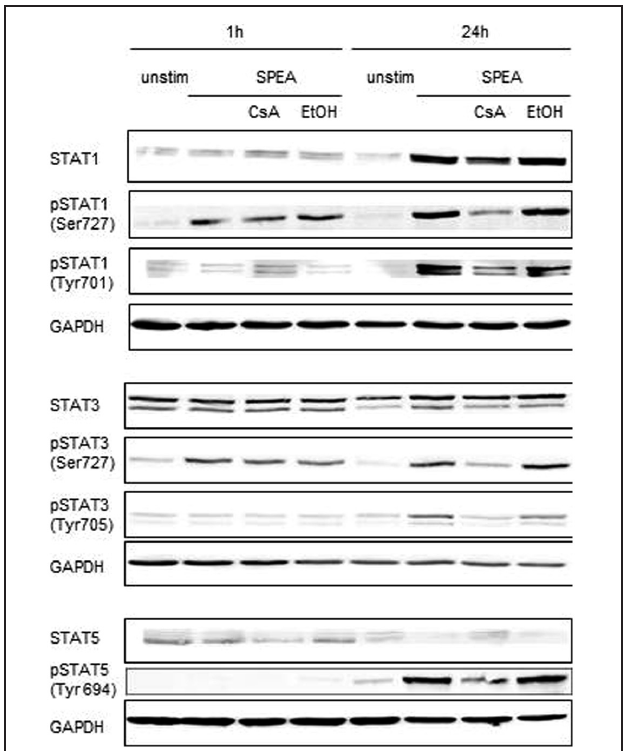
FIGURE 9 | STAT activation after SPEA stimulation. (A) CD14 + monocytes were stimulated for 1 or 24 h with 100 ng/ml SPEA and 1 μ M CsA (Ethanol was used equal to the amount of CsA). Cells were lysed and analyzed by western blotting with specific antibodies against STAT1, phospho-STAT1 (Ser727, Tyr701), STAT3, phospho-STAT3 (Ser727, Tyr 705), STAT5 and phospho-STAT5 (Tyr 694). GAPDH as loading control was displayed. Shown is one representative experiment out of